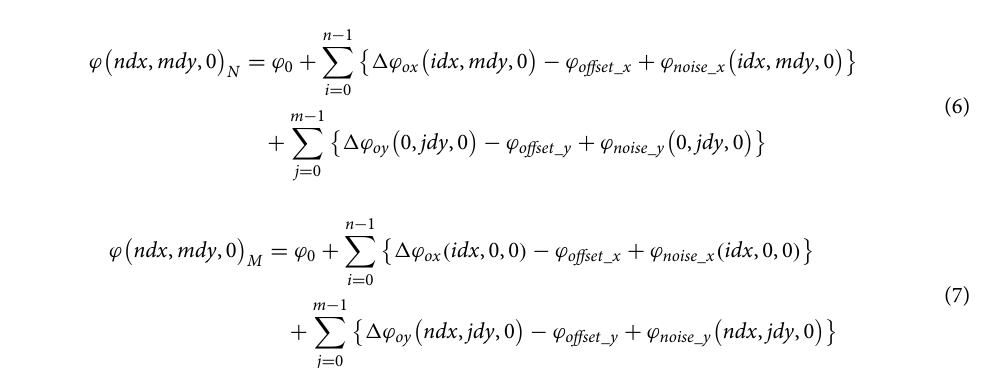
Figure 3. Setup for proof-of-concept experiments using integrated multichannel probe. Blue lines are optical fibers while red lines are electrical cables. LO local oscillator, EOM electro-optic modulator, LD laser diode, PD photodiode, LIA lock-in